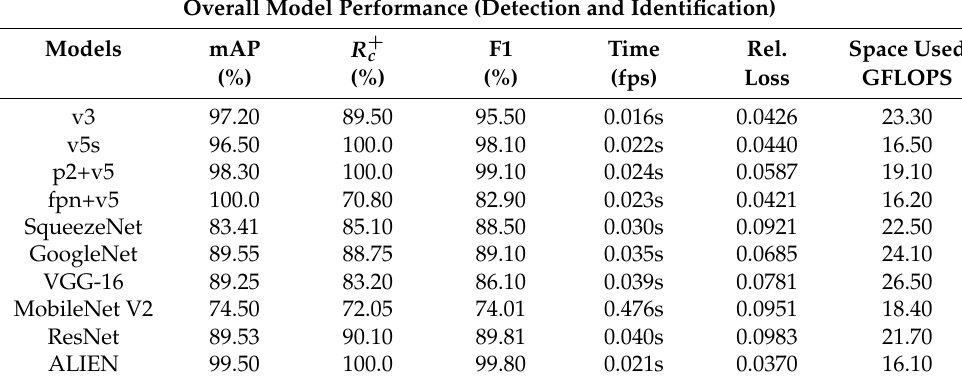
Table 8. Models performance evaluation